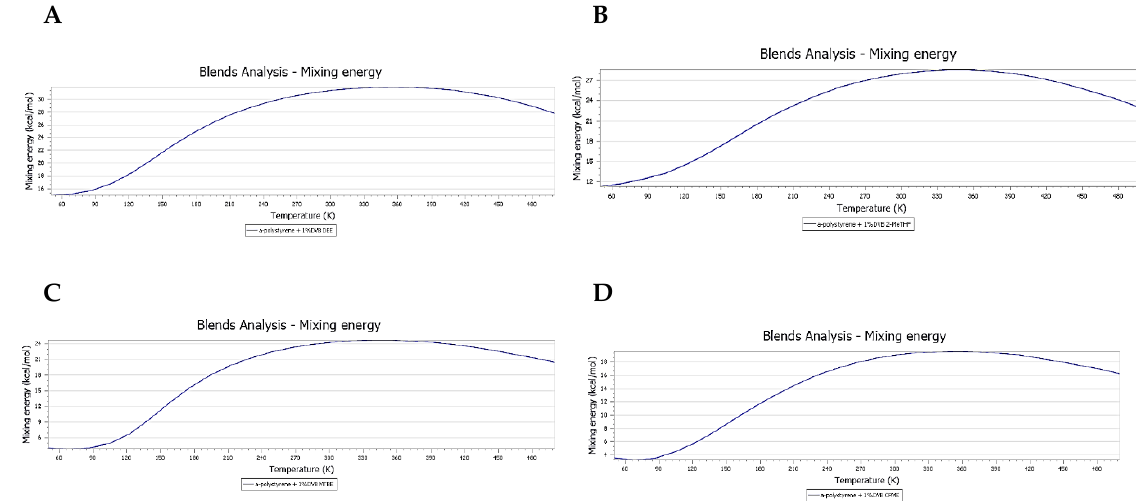
Figure 6. Chart displaying Emix dependence on temperature (50–500 K): ( A ) DEE; ( B ) 2-MeTHF; ( C ) MTBE; and, ( D ) CPME. Emix values at the working temperature in this study (280 K): DEE; 30.9 > 2-MeTHF; 27.4 > MTBE; 23.8 > CPME; 18.5.